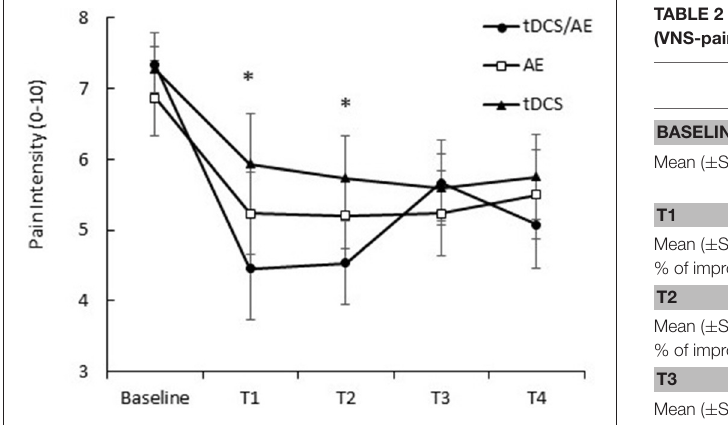
FIGURE 4 | Response of pain intensity (VNS pain). T1, assessment after the fifth day of intervention; T2, assessment after 1 month of intervention; T3, assessment after 1 month of the end of the intervention (follow-up 1); T4, assessment after 2 months of the end of the intervention (follow-up 2). Data presented as mean and standard error. * Statistical analysis demonstrated significant result for T1 ( p = 0.02 ) and at T2 ( p = 0.03 ) between tDCS/AE group and tDCS group.